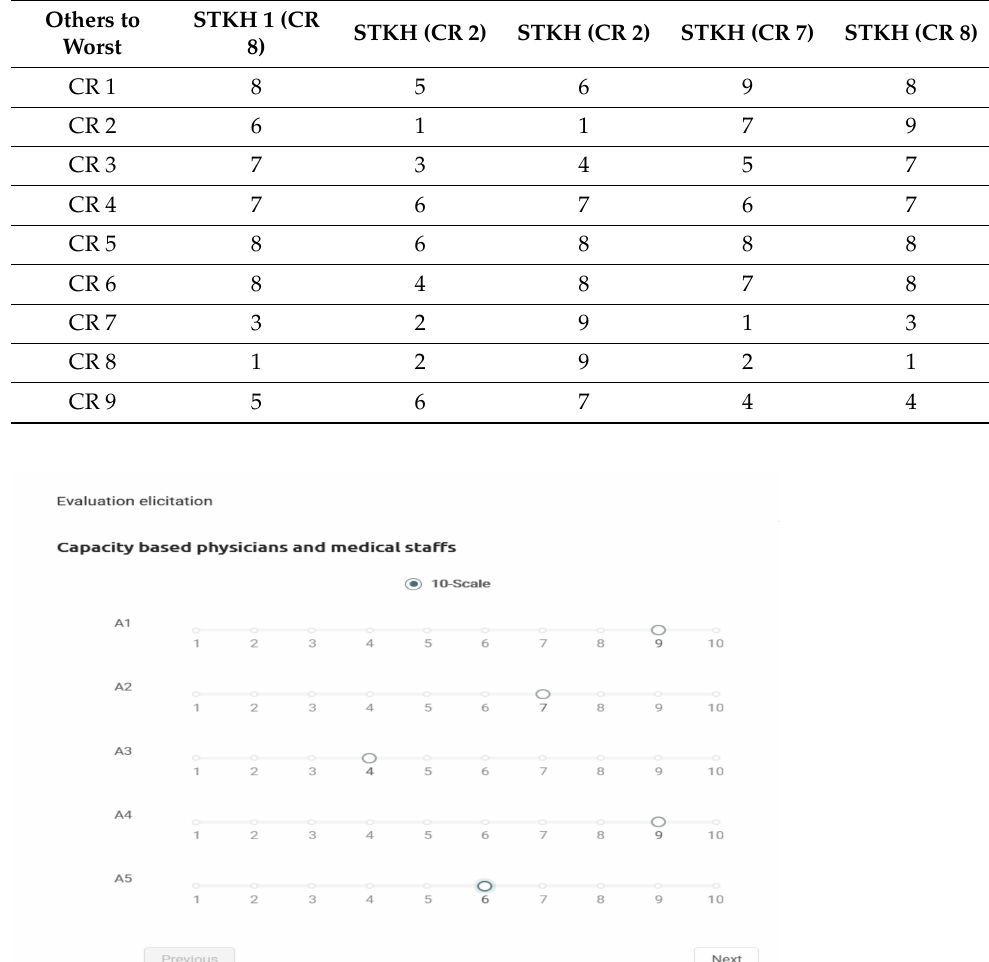
Table A2. Preference values of other criteria over worst criteria by all stakeholders.